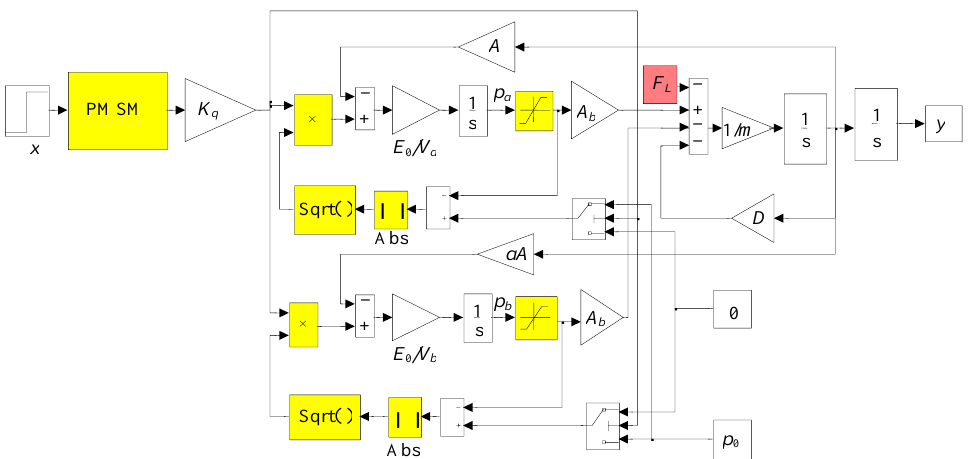
Figure 4. The model of the hydraulic drive with single piston rod cylinder.